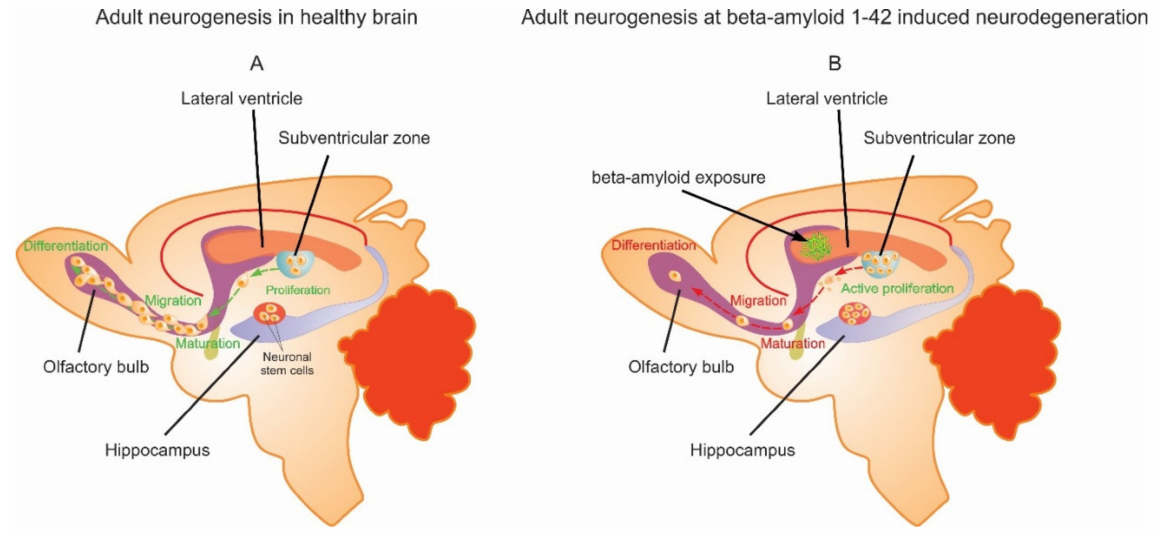
Figure 8. ( A ) Adult neurogenesis in the brains of healthy rats. Here, we depict neurogenesis under normal conditions: stem cell proliferation in neurogenic niches (the SVZ and hippocampus), differ- entiation and migration, maturation, and finally integration into adjacent neural circuits. ( B ) Adult neurogenesis in the brain after aggregated A β (1-42) single exposure. Amyloid exposure resulted in increased stem cell proliferation in neurogenic niches (the SVZ and hippocampus), followed by impaired migration and incomplete